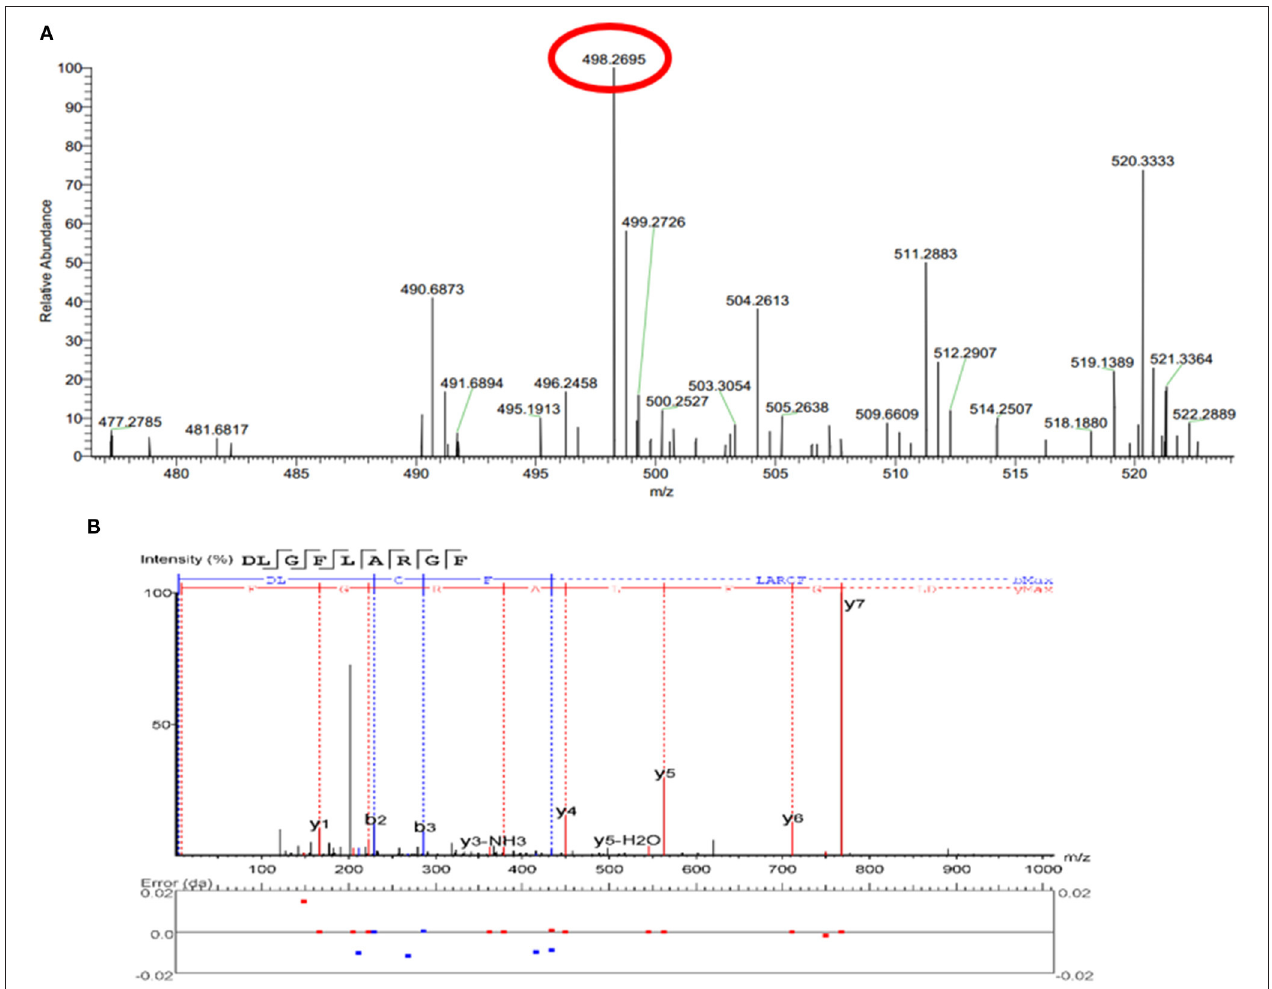
FIGURE 3 | The full MS scan spectrum (A) and the full MS/MS spectrum (B) of DLGFLARGF.